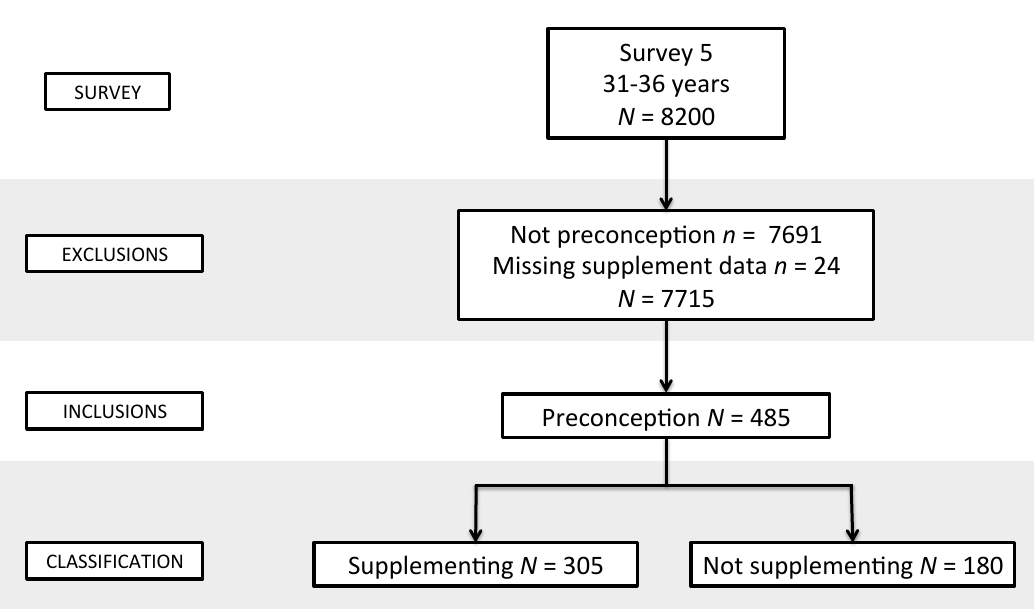
Figure 1. Selection of participants and classification of supplementation status.